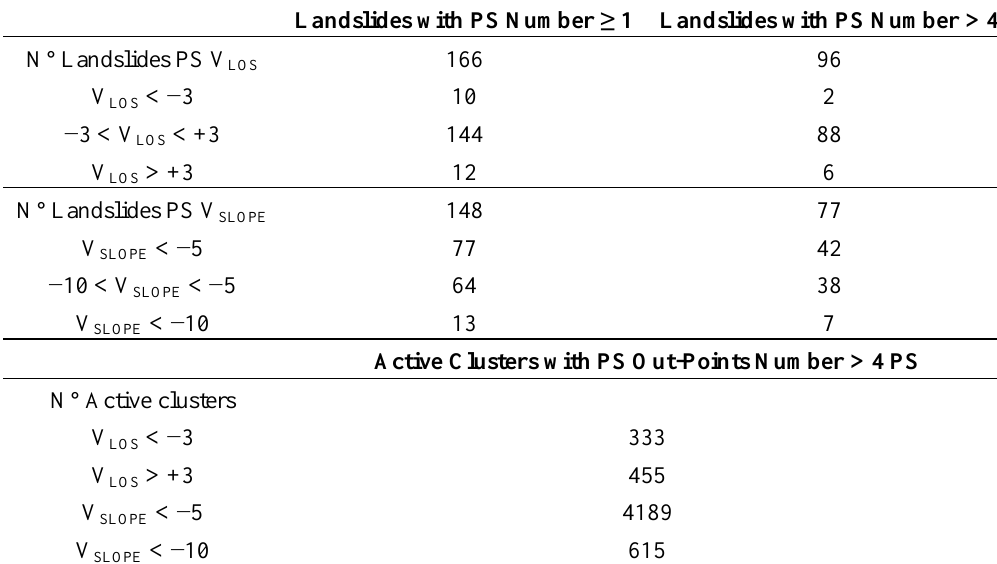
Table 3. Amounts and velocity rates of PS ALOS populations. Landslides with PS Number ≥ 1 Landslides with PS Number >